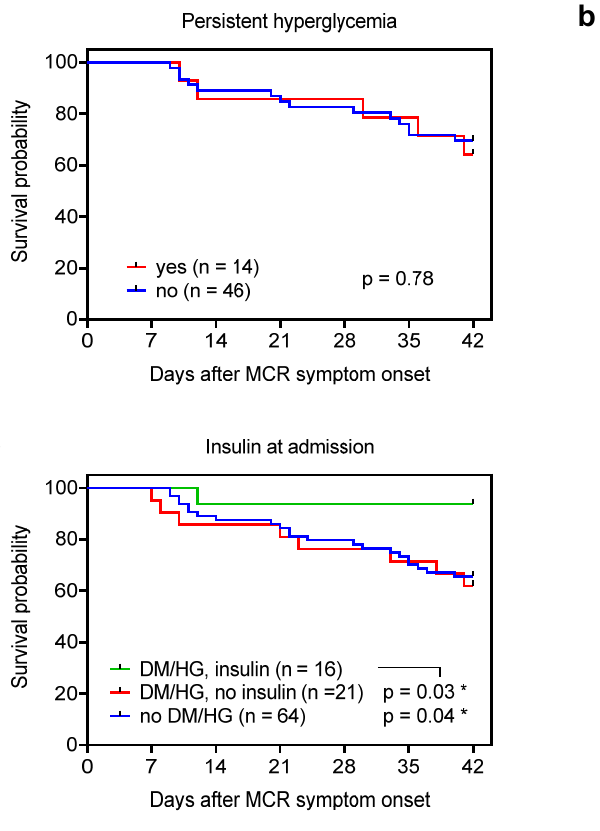
Figure 1. Survival probability depending on ( a ) persistent hyperglycemia, ( b ) presence of severe hyperglycemia, and ( c ) presence of diabetes mellitus (DM)/hyperglycemia (HG) and insulin treatment at admission. Data regarding persistent hyperglycemia and insulin use were available for 60 and 101 out of the 103 patients, respectively. Mantel–Cox log-rank test. MCR = mucormycosis. Factors independently associated with 42-day, all-cause mortality on multivariate lo- gistic regression analysis were neutropenia status (OR 0.35, p = 0.03 for neutropenia with recovery, and OR 5.33, p < 0.001 for neutropenia without recovery; reference: non-neutro- penic patients), ICU admission at time of MCR diagnosis (OR 4.98, p < 0.001), Mucorales- active antifungal prophylaxis prior to diagnosis (OR 3.21, p < 0.01), and lymphoma/mye- loma as underlying malignancy (OR 3.21, p = 0.02) (Table 2). None of the hyperglycemia trends and antidiabetic treatments reviewed in the present study, i.e., persistent hyper- glycemia, severe hyperglycemia, or insulin prescription, were independent predictors of 42-day mortality. Table 2. Multivariable logistic regression model of predictors of 42-day mortality since MCR symptom onset. Independent Predictor